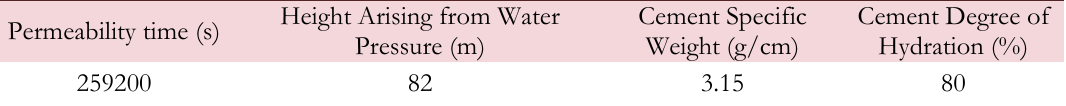
C OMPRESSIVE S TRENGTH